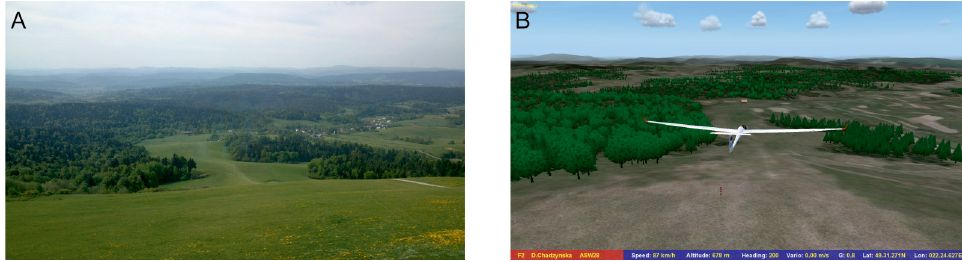
Fig. 13. Comparison of a photograph of Bezmiechowa airfield (A) with its visualization in the Condor game